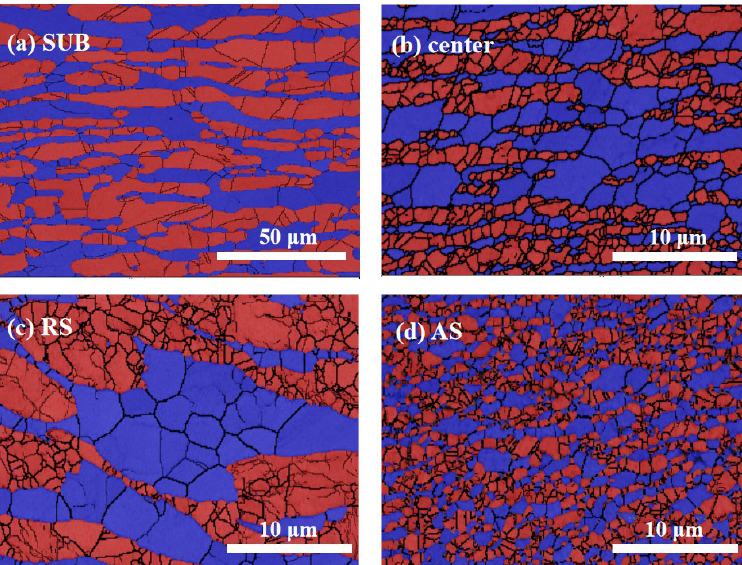
Figure 3. Phase maps of ( a ) SUB, ( b ) center, ( c ) RS, and ( d ) AS (austenite and ferrite are in red and blue respectively). Note that the scale bars in ( a – d ) are different.